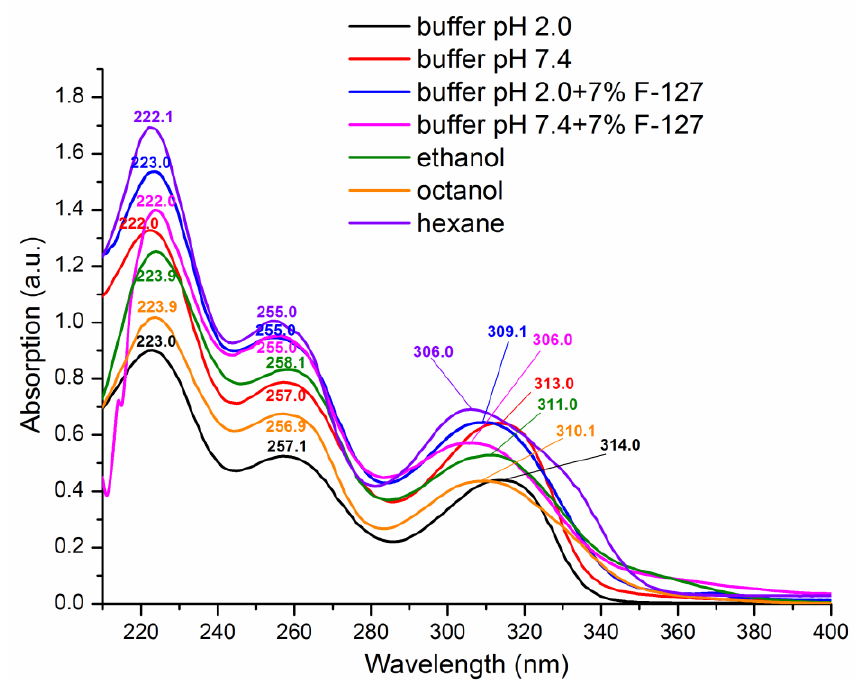
Figure 3. Absorption spectra of UMF in two pure buffers (pH 2.0 and pH 7.4), with F-127 (7.0 w/v%), and in organic solvents (n-hexane, ethanol,